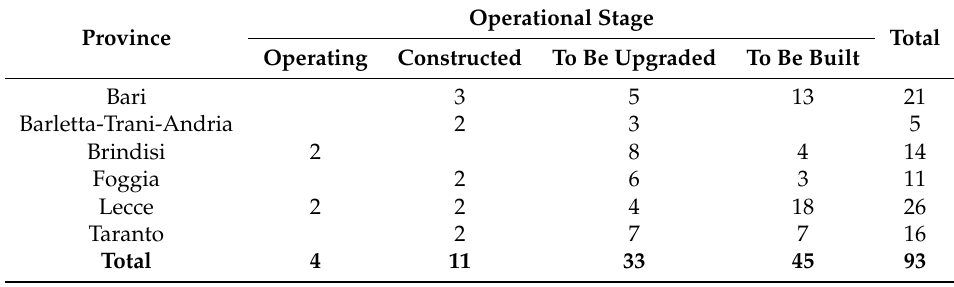
Table 4. Classification of wastewater plants in Puglia based on current e ffl uent discharge and plant size (2015).